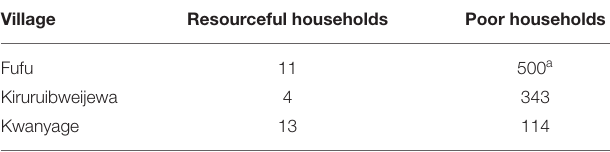
TABLE 6 | Proportion of rich and poor households in the selected study villages. Village